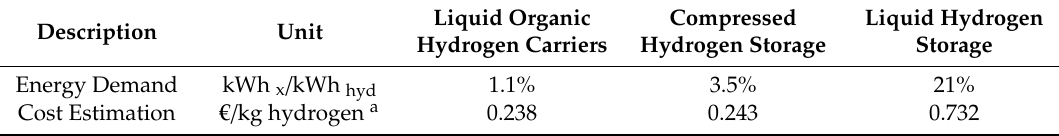
Table 2. Energy and cost demands of hydrogen-storage systems (Adapted from [3]).